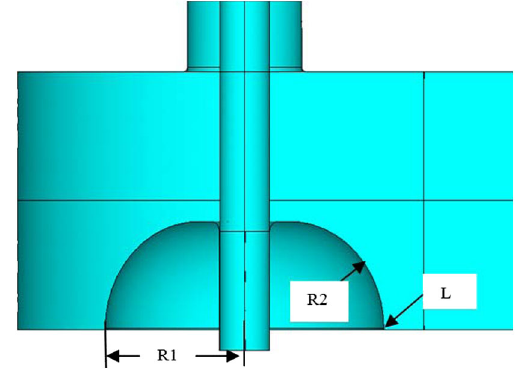
FIG. 6. Doorknob geometry and optimization parameters.